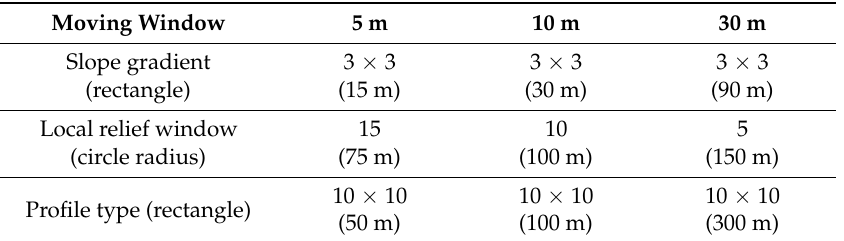
Table 1. Parameters of the moving window sizes in pixels (px) used in this approach for the three different pixel resolutions. Cell size in meters are shown in